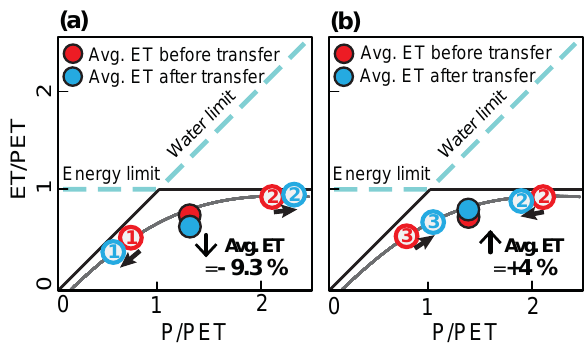
Figure 12. Budyko curve and increase or decrease of average ET when transfer of water from a higher location to a lower location is included. (a) 500mmyr − 1 of transfer from site 1 (3000m altitude, lower aridity index) to site 2 (300m altitude, higher aridity index) decreases the average ET by 9.3%. (b) 500mmyr − 1 of transfer of water from location 2 (altitude 300m, higher aridity index) to location 3 (altitude 10m, lower aridity index) increases the average ET by